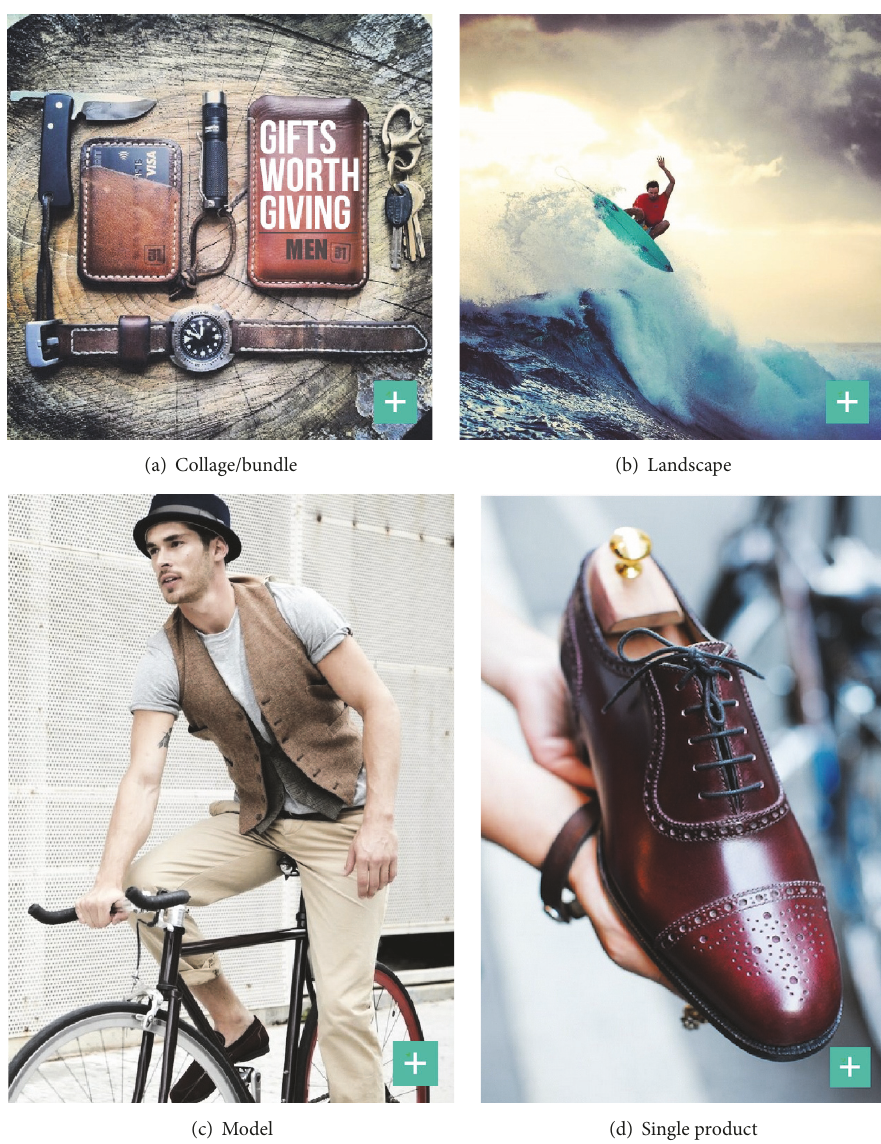
Figure 12: Different types of possible Hook photos.